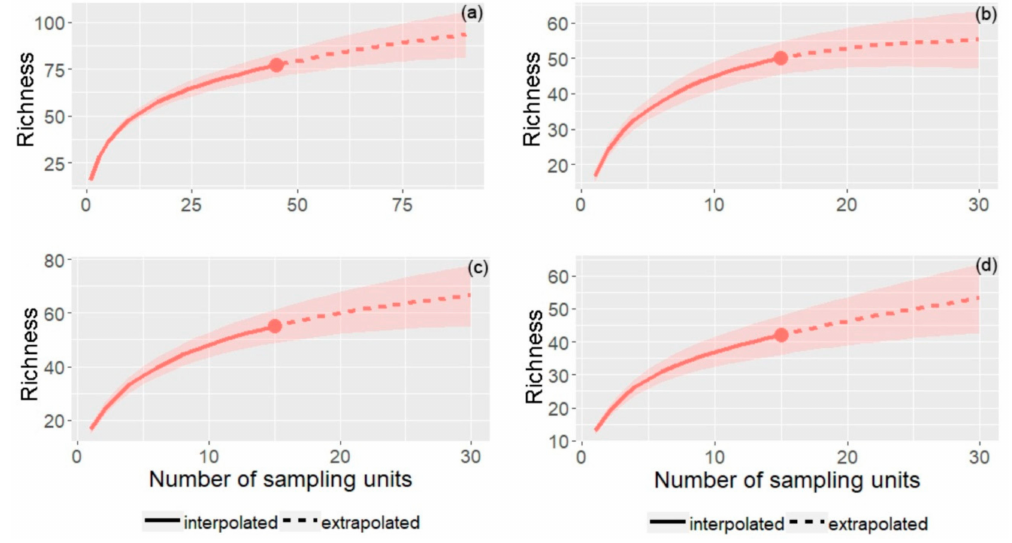
Figure 3. Species accumulation curve of AMF species across a clay gradient (LCC: Low Clay Content, MCC: Medium Clay Content, HCC: High Clay Content). ( a ) Total Richness, ( b ) LCC, ( c ) MCC, ( d )